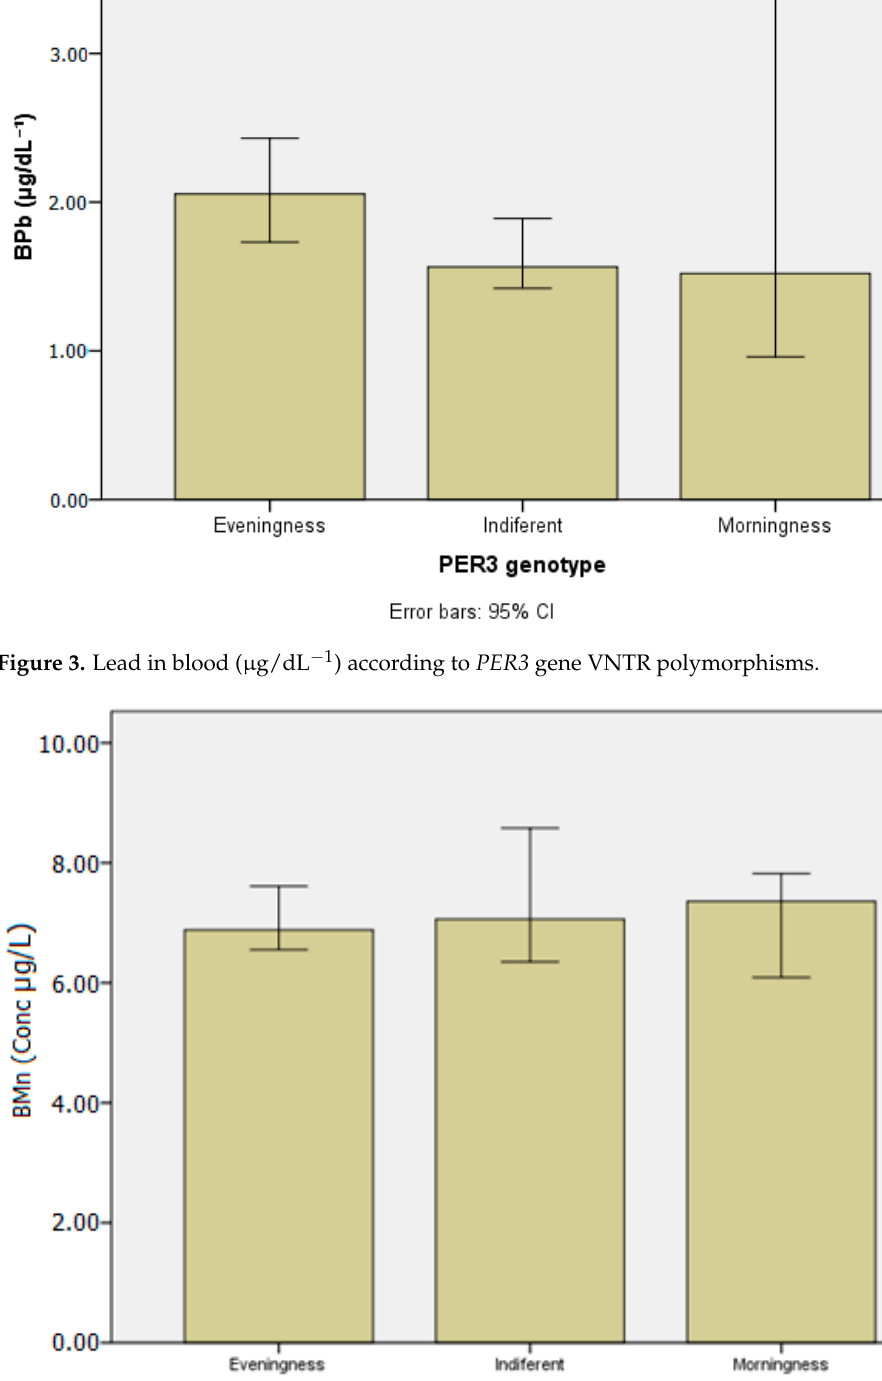
Figure 5. Manganese in urine ( μ g g − 1 creat) according to PER3 gene VNTR polymorphisms.